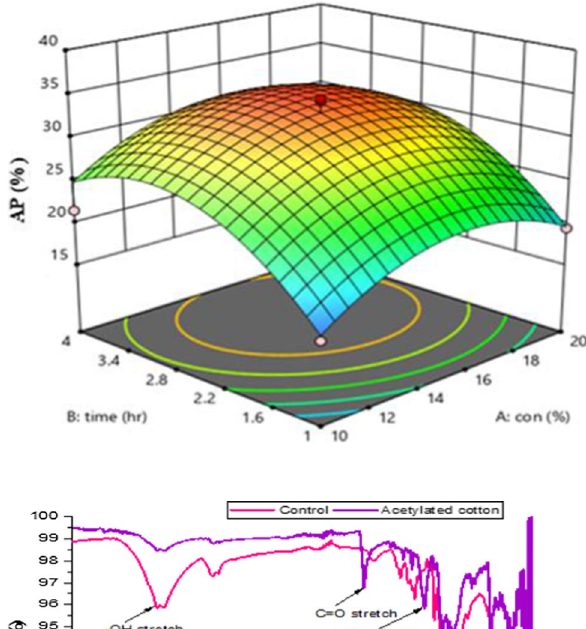
Fig. 5 FTIR spectra of control or cotton fabric and acety- lated cotton fabric